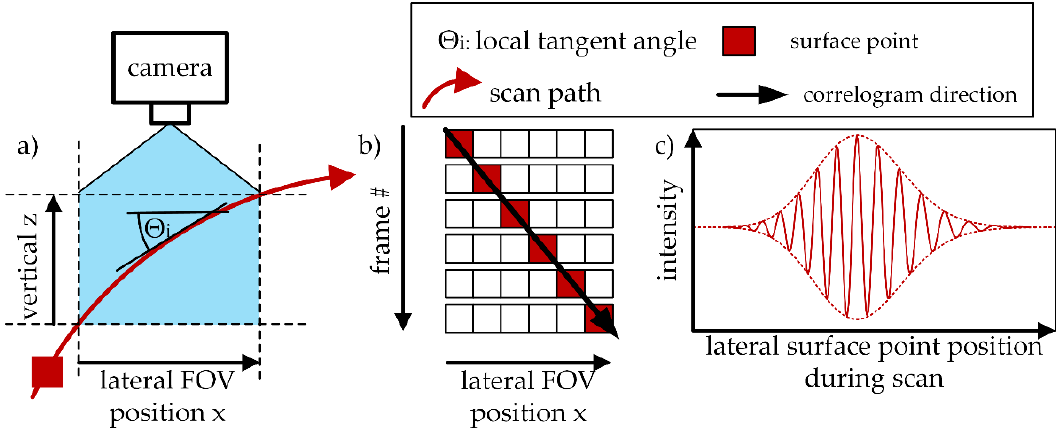
Figure 1. Correlogram recording in rotatory lateral scanning white light interferometry (LSWLI). ( a ) x-z orientation of the scan path in the field of view (FOV) of the camera. ( b ) Surface position in each frame of a LSWLI image series. ( c ) Correlogram of the observed surface point.